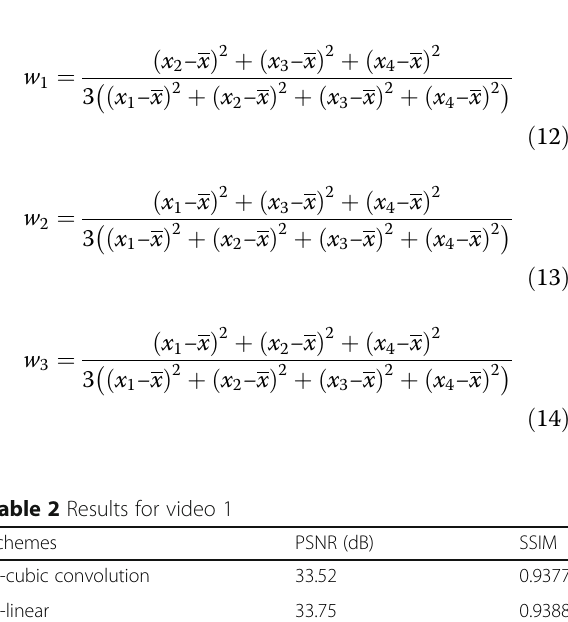
Fig. 3 ViSAR dataset includes three different videos; one frame from each video is seen